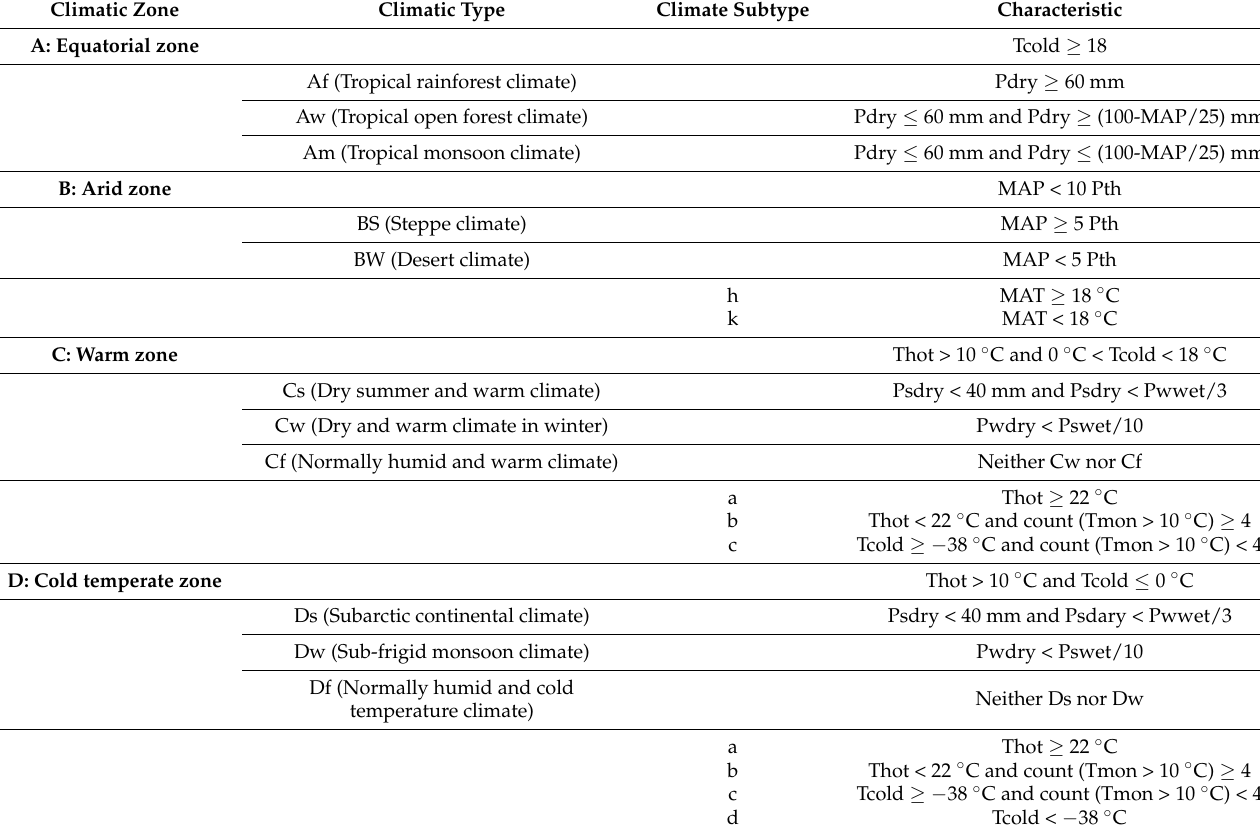
Table 2. Division and definition criteria of the Köppen climate zone